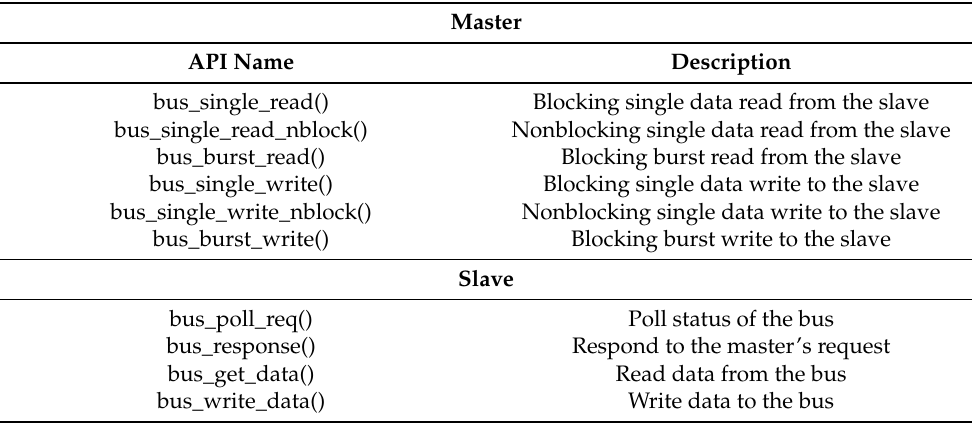
Table 3. Synthesizable communication APIs’